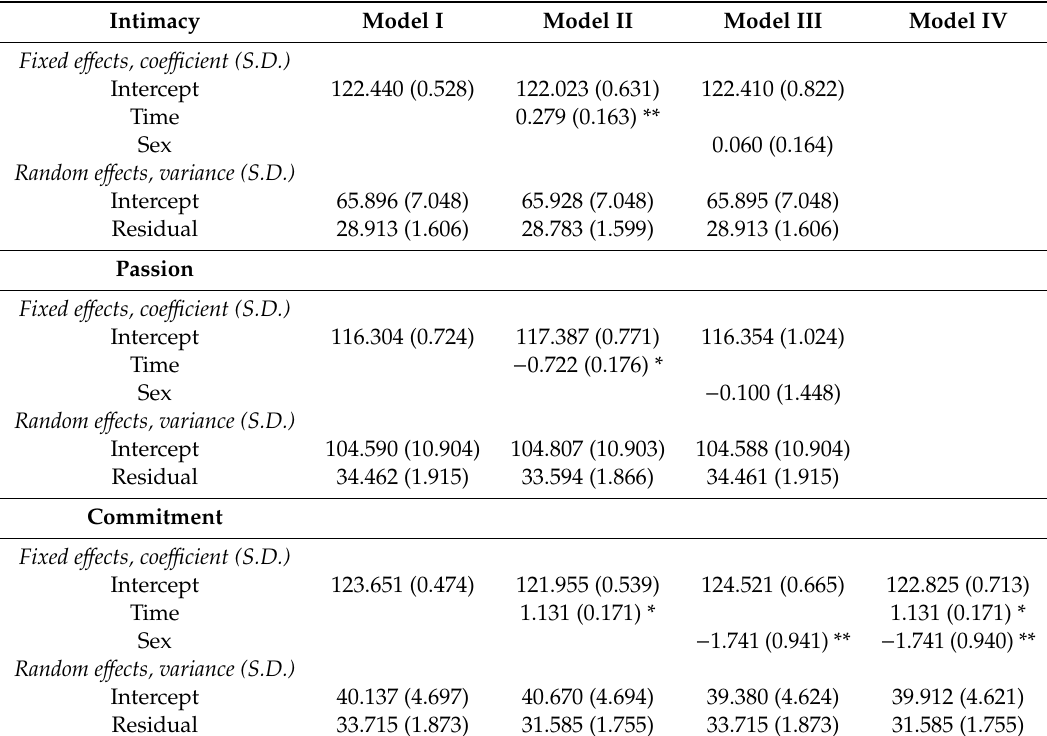
Table 12. Linear mixed-e ff ects regression model